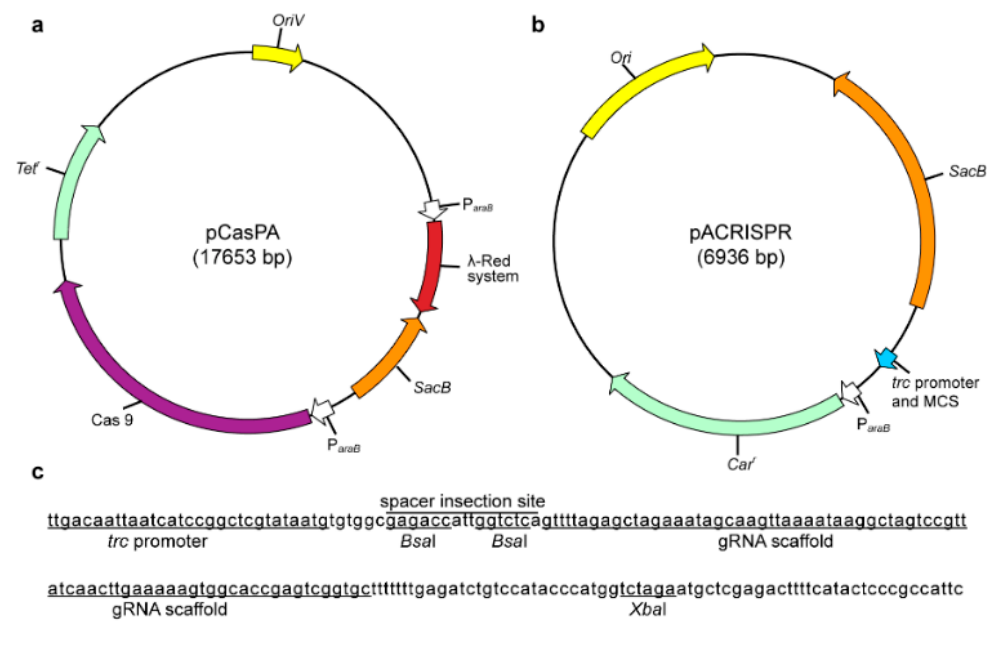
Figure 2. The map of the two–plasmid CRISPR–Cas9 system and multiple cloning sites. ( a ) Genetic and physical map of the plasmid pCasPA. RNA–guided Cas9 protein and the phage λ –Red recombination system were induced under the L–arabinose–inducible araB promoter (P araB ). OriV , incP origin of replication. Tet r , the tetracycline–resistance gene of E. coil and P. fulva for selection. SacB , the counter–selectable marker gene used for plasmid curing after genome editing. ( b ) Genetic and physical map of the plasmid pACRISPR. Ori , high–copy–number origin of replication. trc promoter, the sgRNA expression promoter. MCS, multiple cloning sites. Car r , the tetracycline–resistance gene of E. coil and P. fulva for selection. SacB , the counter–selectable marker gene used for plasmid curing after genome editing. ( c ) The sequence of the MCS of the pACRISPR. Bsa I sites, for the insertion of sgRNA. Xba I and Hind III sites, for Gibson assembly of the homologous repair arms.